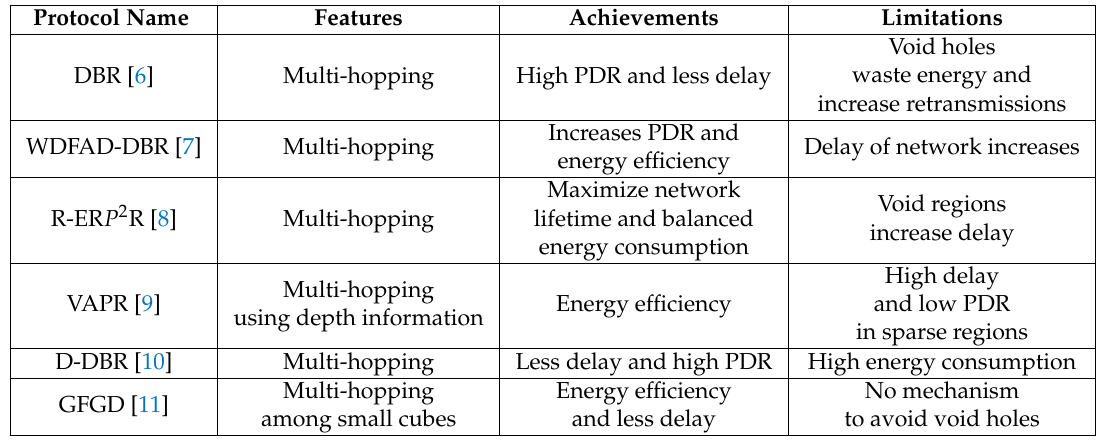
Table 1. Comparison of Single Path Routing